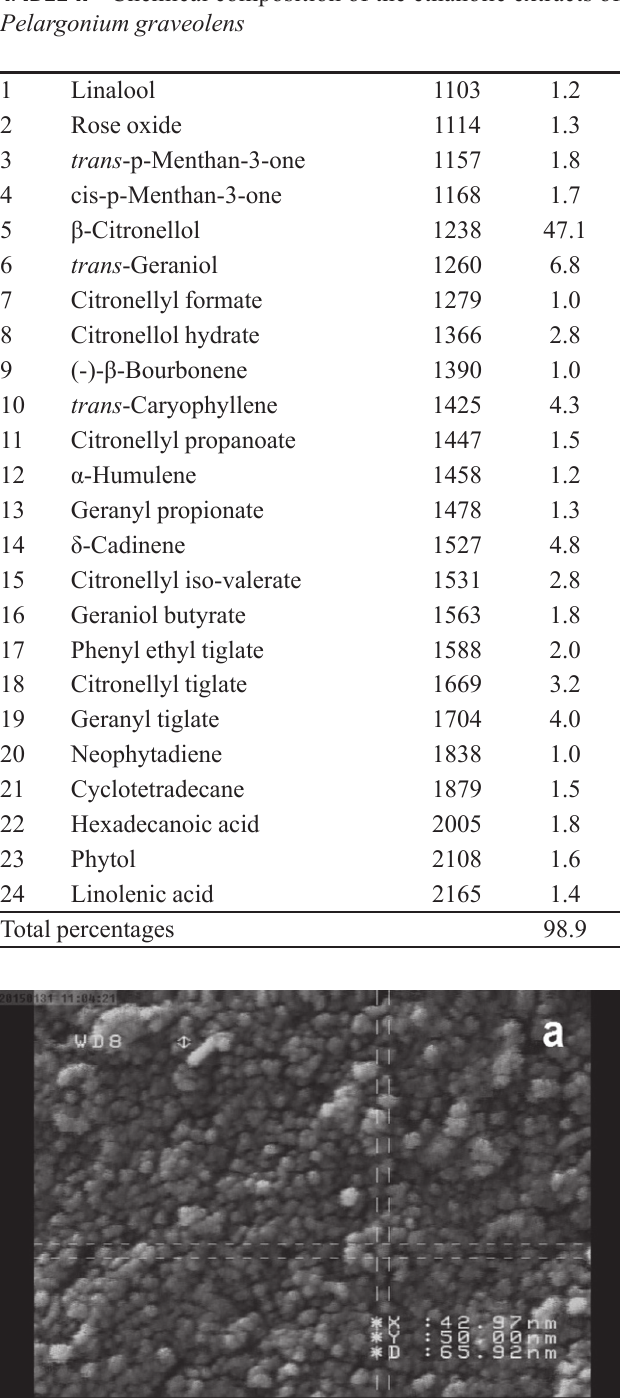
FIGURE 1 ‑ FE‑SEM images of the prepared Mn‑Ni@Fe